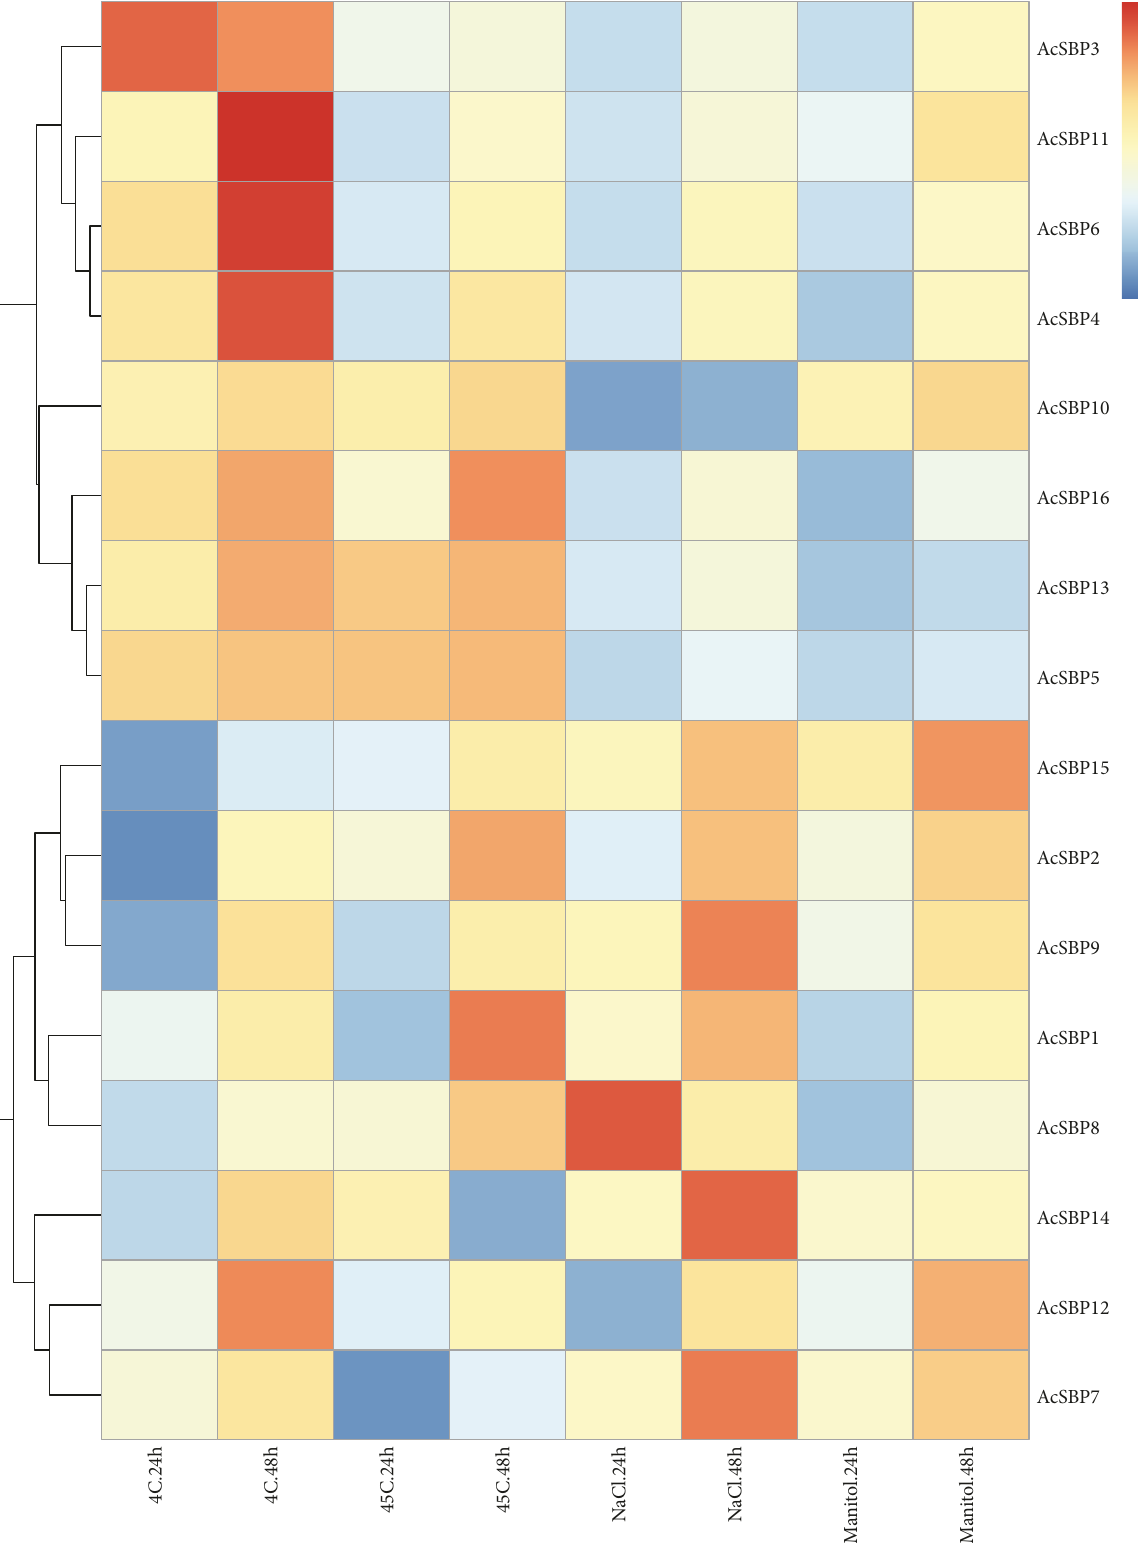
Figure 6: A heat map of expression pro fi les of SBP genes under abiotic stresses [cold (4 ° C), heat (45 ° C), salt (NaCl), and drought (mannitol)]. qRT-PCR was used to analyze the relative expression level of each SBP gene. The expression level of pineapple actin was used as the internal control to standardize RNA samples for each reaction, and the expression at 0h was taken as 1 (data not shown). Expression level can be understood using the given